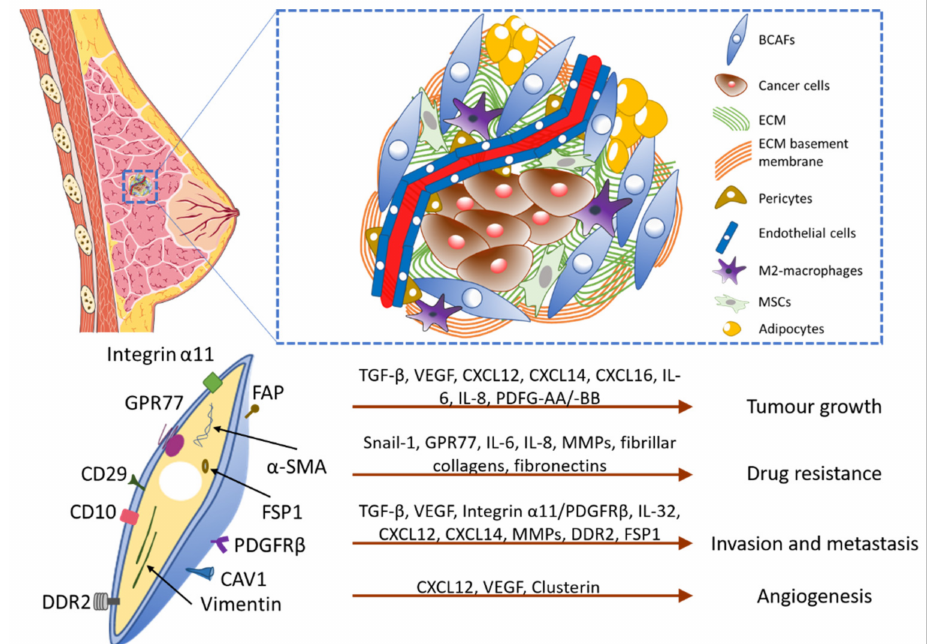
Figure 1. Breast cancer tumor microenvironment, BCAF biomarkers, and pro-tumorigenic functions. The breast cancer tumor microenvironment possesses BCAFs, ECM components and various other cell types, including endothelial cells, M2-macrophages, mesenchymal stem cells (MSCs), adipocytes, and pericytes. BCAFs actively contribute to the production of ECM components and promote M2-macrophages recruitment and metastasis. In the bottom half, biomarkers of BCAFs and the mechanisms of pro-tumorigenic functions are displayed. Some of the biomarkers are Integrin α 11, GPR77, CD10, DDR2, α -SMA, Vimentin, FSP1, CD29, CAV1, FAP, and PDGFR β . BCAFs contribute to tumor growth, drug resistance, invasion, and angiogenesis by secreting various chemokines (CXCL16, CXCL14 and CXCL12), growth factors (TGF- β and VEGF), interleukins (IL-6, IL-8, and IL-32), ECM (fibrillar collagens and fibronectins) and possessing other factors/receptors, such as MMPs, Snail-1, GPR77, Integrin α 11/PDGFR β , DDR2, and